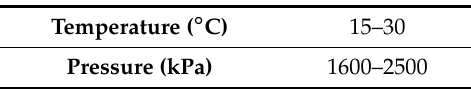
Table 1. Input parameters